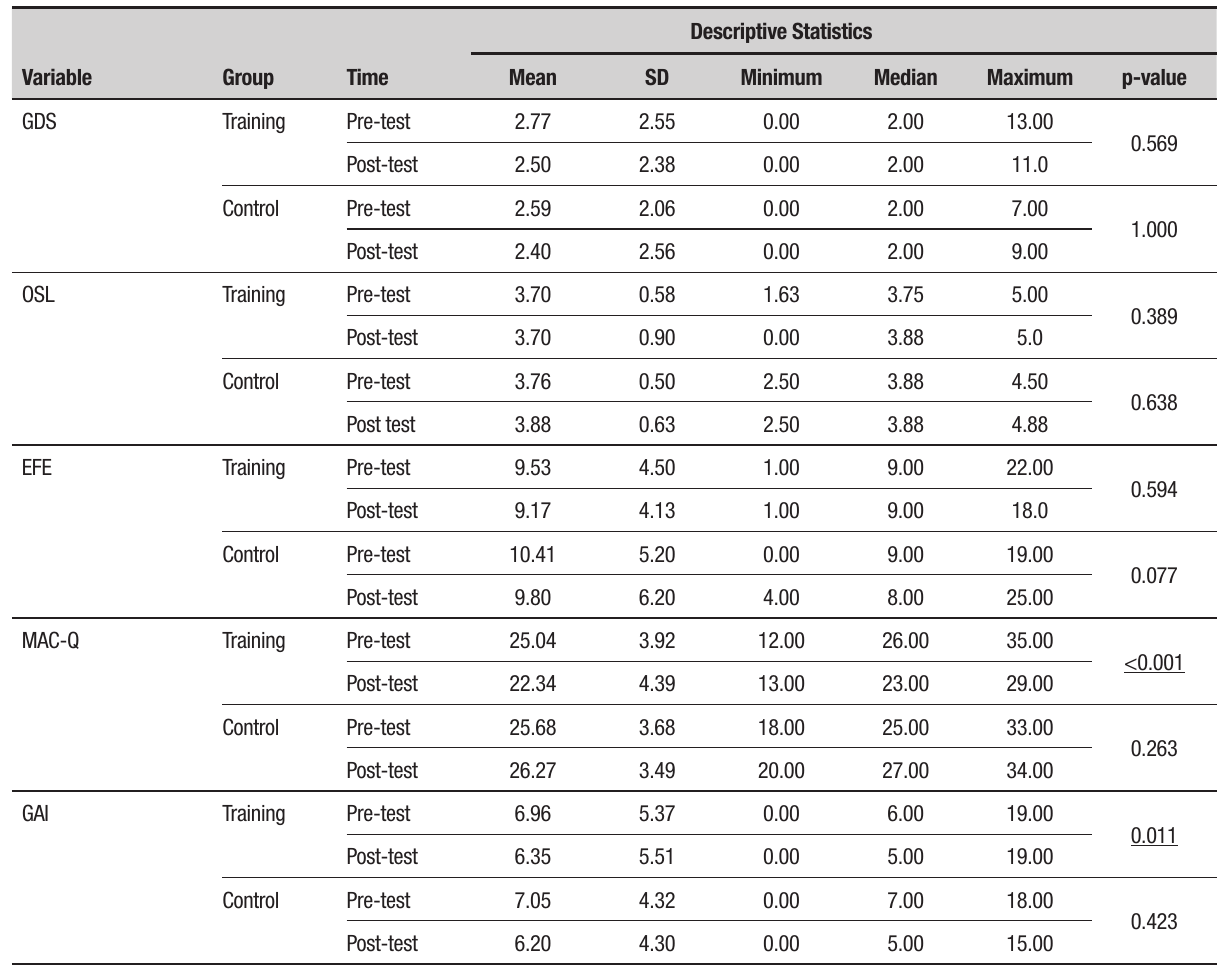
Table 3. Comparison pre and post-test between training and control groups.